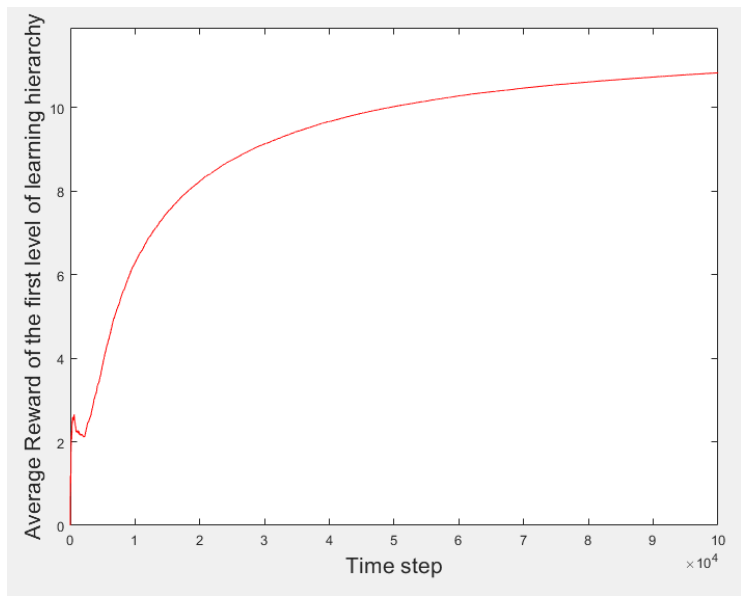
Figure 5. Initial part of first-level learning results before the process converges.